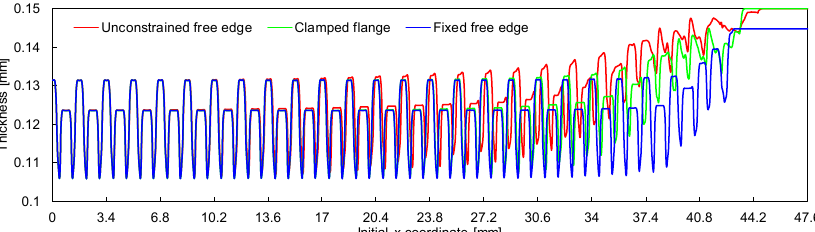
Figure 8. Thickness distribution on the BPP along the x -direction using three different boundary conditions in the flange region and considering plane strain conditions.